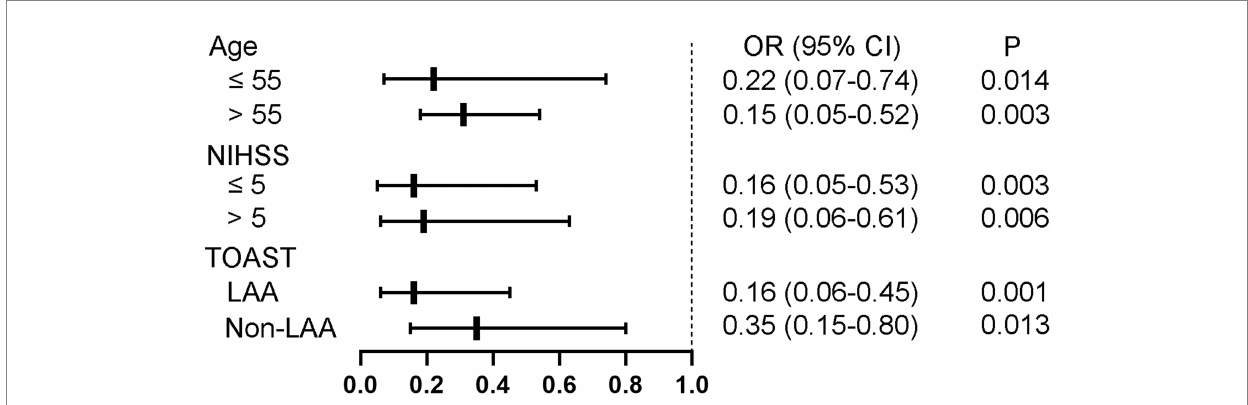
FIGURE 2 Subgroup analysis regarding nTreg/mTreg ratio according to age, NIHSS score, and TOAST classification. nTreg, naïve regulatory T cells; mTreg, memory regulatory T cells. NIHSS, National Institute of Health Stroke Scale; TOAST, trial of org 10,172 in acute stroke treatment; LAA, large artery atherosclerosis.